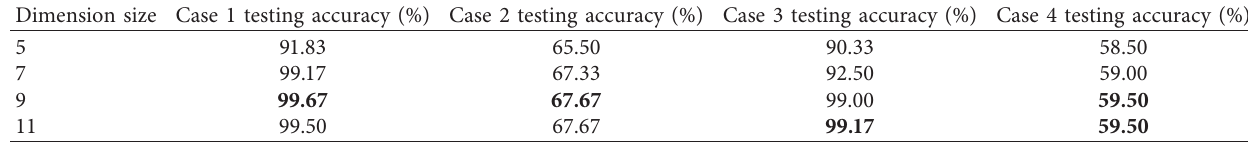
Figure 24: The WSD of 192 statistical features of training Table 19: Bearing fault diagnosis results obtained by the OFS-LMMC-SVM.